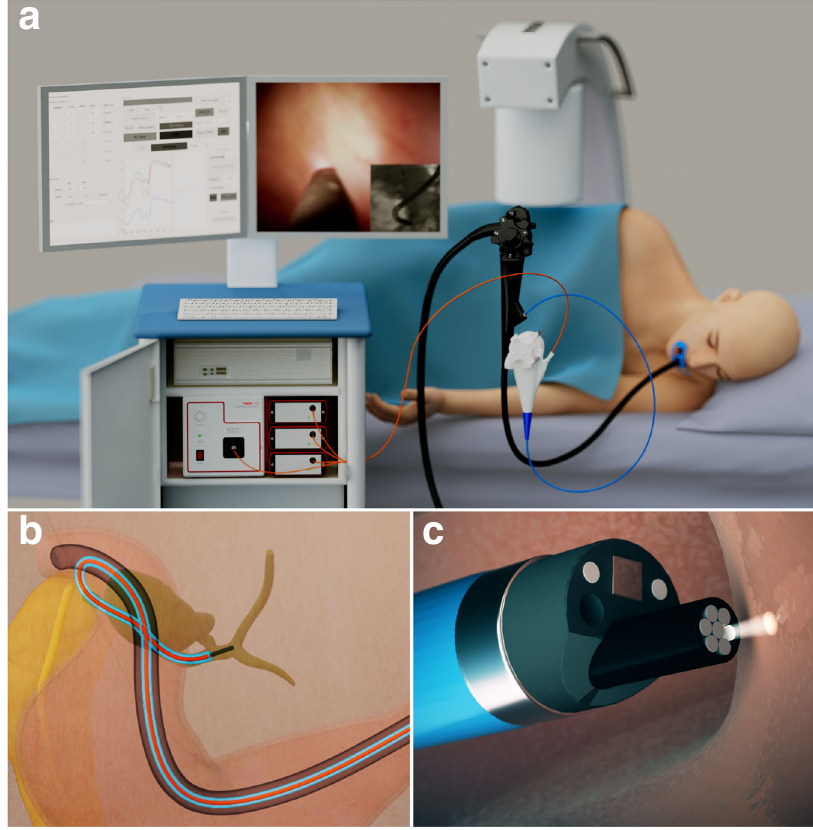
Fig. 1 | In vivo clinical spectroscopic measurements in the bile duct during endoscopic retrograde cholangiopancreatography (ERCP) procedures. a An illustration depicting LSS-DRS measurements of the bile duct wall with the endo- scopic light scattering spectroscopy system. A patient is positioned on an X-ray tableand aduodenoscopewith acholangioscopeplacedinsidetheduodenoscope working channelis inserted into the duodenum. The miniatureLSS-DRS fi beroptic